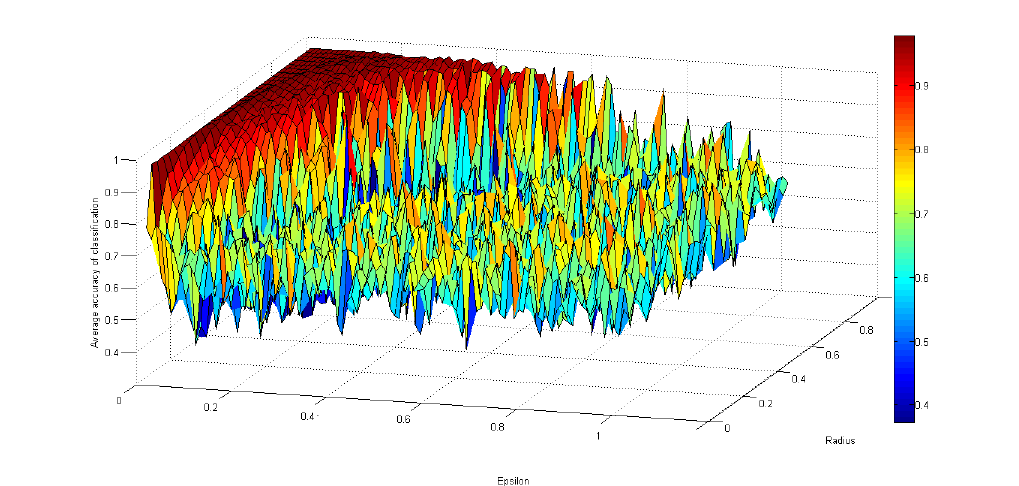
Figure 2. Results of classification accuracy for SVM with RBF kernel, 5 × CV5 test, ε concept-dependent granulation; Wisconsin Diagnostic Breast Cancer data set; Epslilon = is descriptors indiscernibility ratio, Radius = granulation radius.